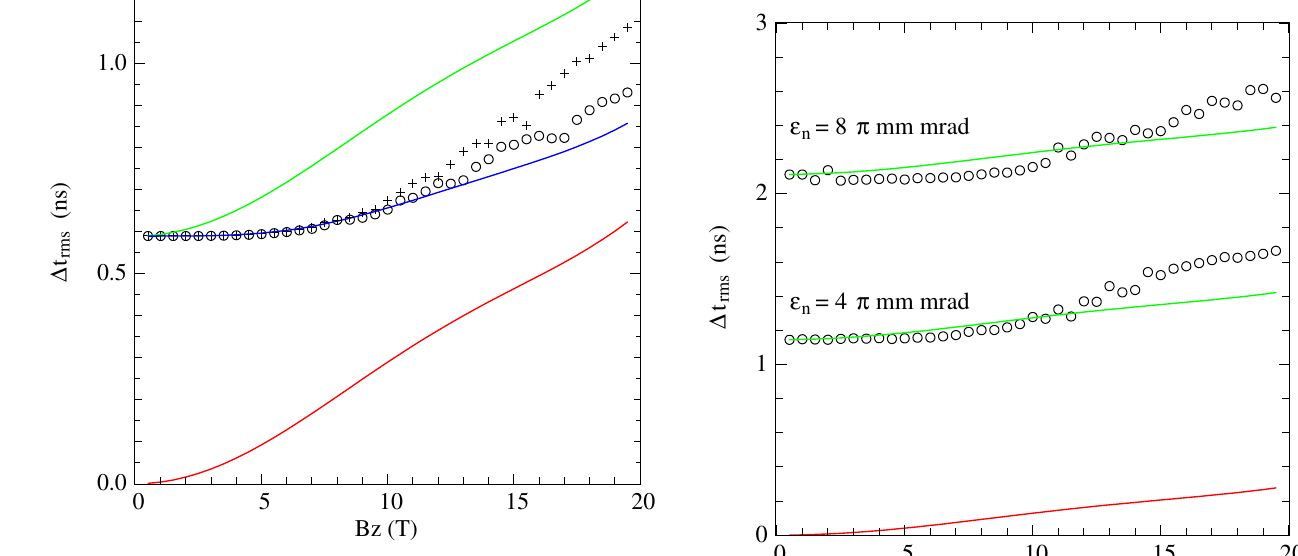
FIG. 5. Comparison of the simulated (circles and pluses) and analytic calculation (red, green, and blue curves) of (cid:1) t rms for a beam with finite extent, axial velocity tilt, and normalized edge emittance of 2 (cid:4) mm mrad . The circles are from the case with the solenoid that is mostly fringe, and the plusses from the solenoid that is nearly hard edged. The green curve is the sum and the blue the geometric sum of the analytic solution and (cid:1) t rms from the simulation with no solenoid field. The analytic (cid:1) t rms does not include either the tilt or the thermal spread.